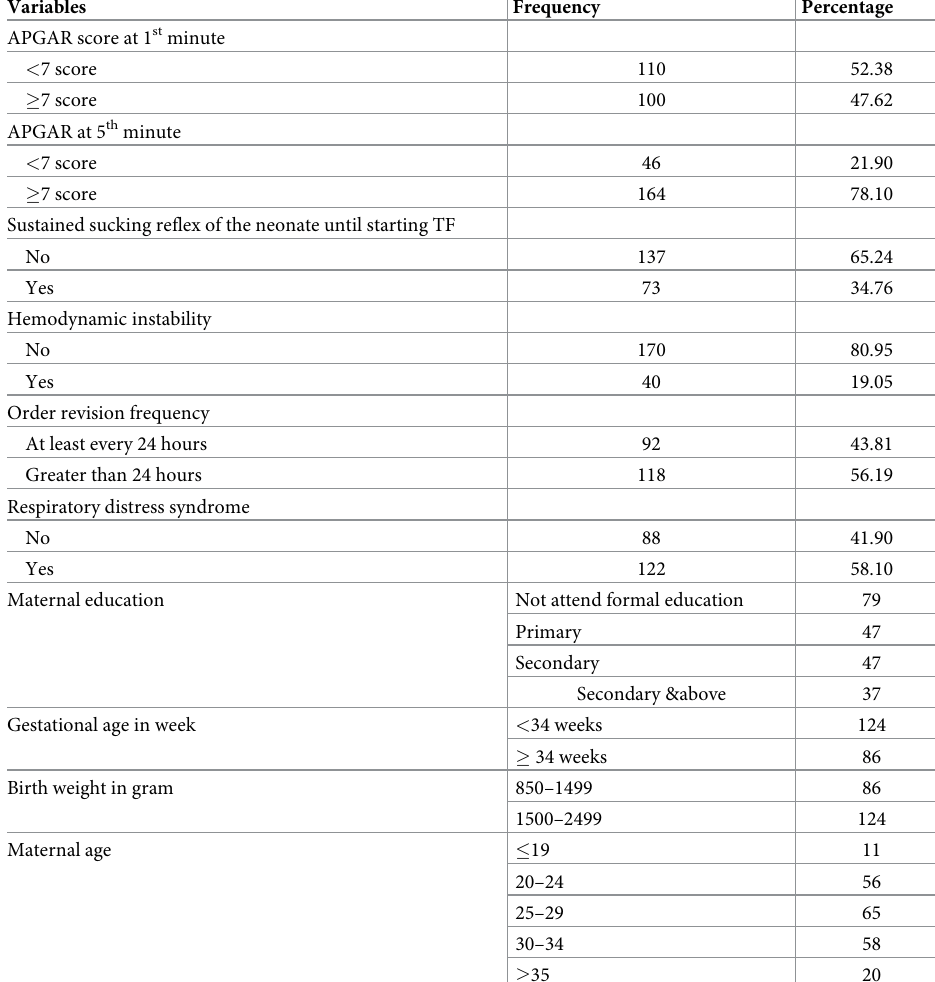
Table 2. Characteristics of neonates and their mothers ‘admitted in NICU of DMCSH, FHCSH, and TGCSH com- prehensive specialized hospitals, Amhara, Northwest Ethiopia, 2020. Variables